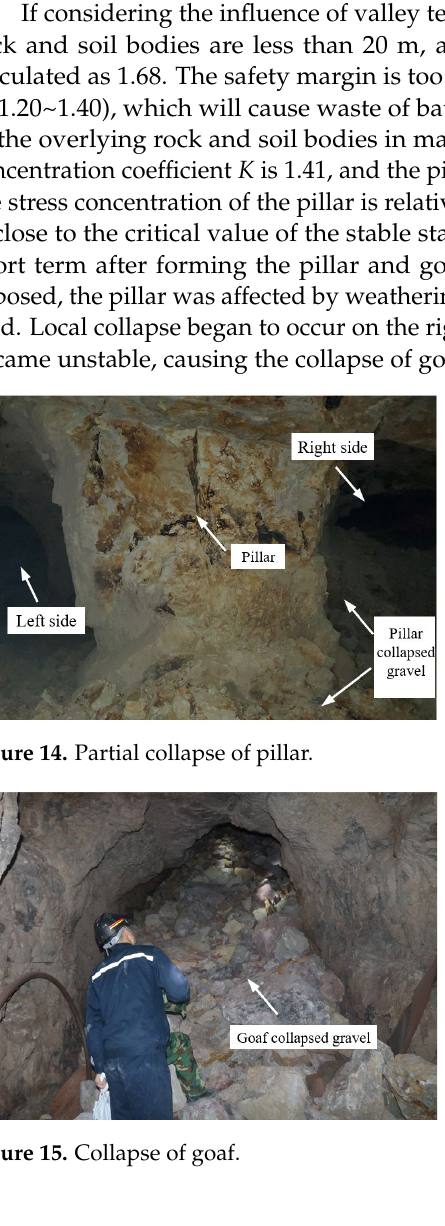
Figure 13. Sectional view of 6# exploration line of a sedimentary bauxite mine in Shanxi.